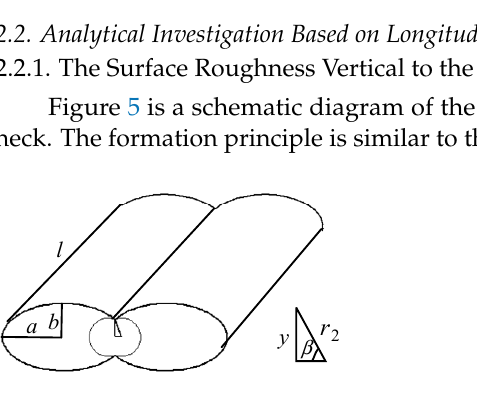
Figure 5. Schematic diagram of the formation of the longitudinal bonding neck.